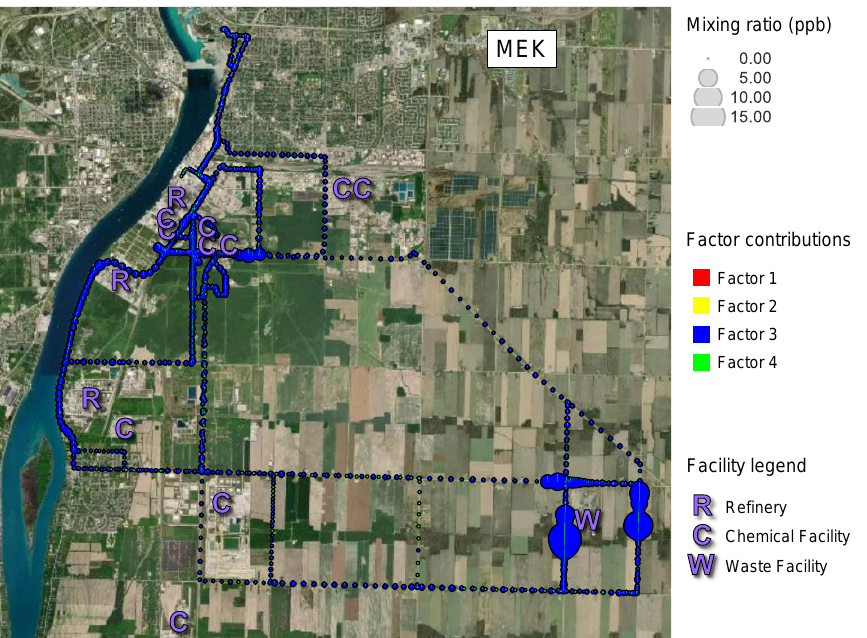
Figure 7. Contributions of each of the four local factors to MEK mixing ratios as a function of measurement location while mobile. The diameter of each pie denotes the MEK mixing ratio and the size of each wedge within each pie represents the relative contribution of each factor for that measurement period.